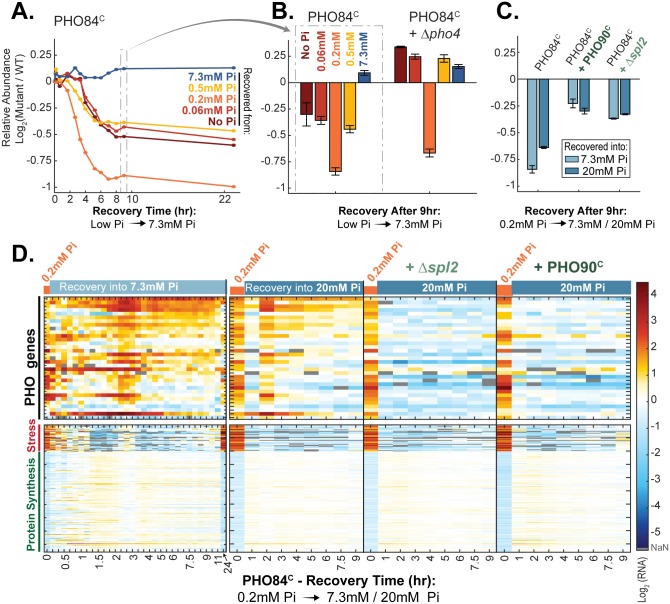
The recovery phenotype of the PHO84-constitutive strain depends on the Pho4-target gene induction.(A) Constitutive expression of the high-affinity PHO84 transporter limits recovery from phosphate starvation: Competition experiments are the same as in Fig 4C but for cells that express PHO84 using the constitutive TDH3 promoter (PHO84C). Note that PHO84C cells recover with a delay and that the delay is particularly significant when cells are recovered from a medium containing intermediate phosphate levels (0.2 mM Pi). During growth in 0.2 mM Pi, wild-type cells have a long preparation time, while PHO84C triggers Pho4-target genes at a delay; see S5A Fig. The data in (A) are from 1 replicate; see (B) for additional supporting data. (B) The recovery phenotype of PHO84C depends on Pho4-targeted gene expression: The experiments in (A) were repeated for PHO84C and for PHO84C with Δpho4 cells. Shown is the (log2) relative abundance after 9 hours of recovery into 7.3 mM Pi. The data in (B) are the mean and standard error of 3 replicates. (C–D) The recovery phenotype of PHO84C is partially rescued by increasing the phosphate influx during recovery: Experiments performed as in (A) for the indicated strains and for recovery (from 0.2 mM Pi) using rich media containing a higher level of phosphate (20 mM compared to 7.3 mM Pi). PHO90C denotes constitutive expression of the low-affinity transporter, while Δspl2 refers to the deletion of the Pho90 inhibitor SPL2. Both mutations were added to the PHO84C strain, and the double mutants were competed against wild-type cells. The (log2) relative abundance after 9 hours of recovery as in (B) is shown in (C), while expression profiles of genes as in Fig 4B are shown in (D). The data in (C) are the mean and standard error of 2 or 3 replicates. The data in (D) are from 1 replicate. Additional data for recovery of PHO84C strain (from 0.06 mM Pi) are found in S6E Fig. The conclusions of (D) are further supported by the Venus reporter (an independent experiment that uses an independent construct); see S4 Data. The raw data for (A–C) are available in S4 Data. The raw data for (D) are available in S2 Data. NaN, not a number; Pi, inorganic phosphate; WT, wild type.